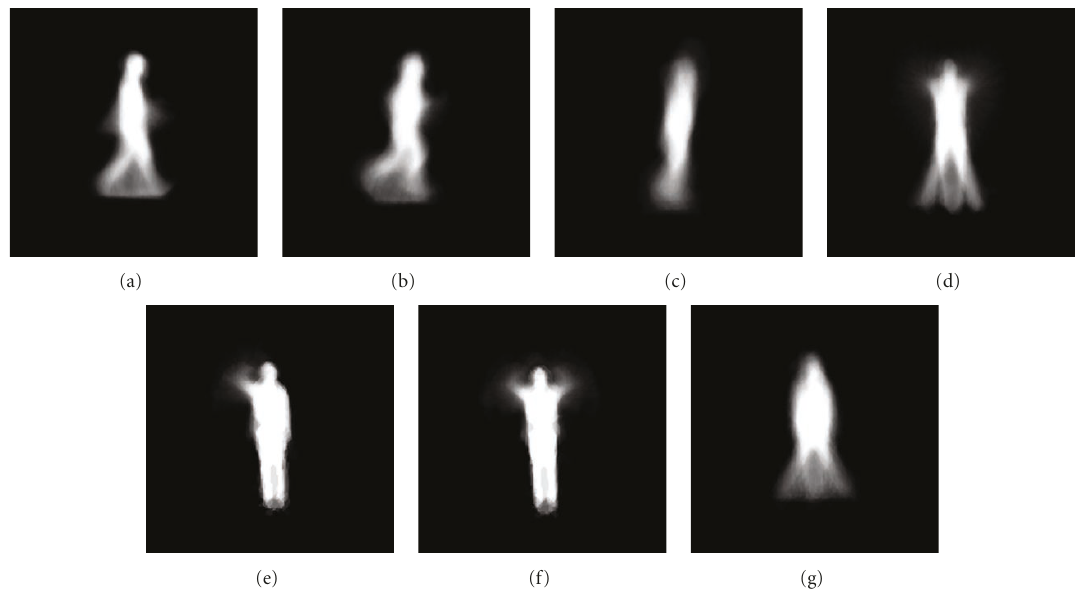
Figure 9: MEH of 7 actions. (a) Walking, (b) Running. (c) Jumping. (d) Jumping Jack. (e) Waving one hand. (f) Waving two hands. (g) galloping-sideways.